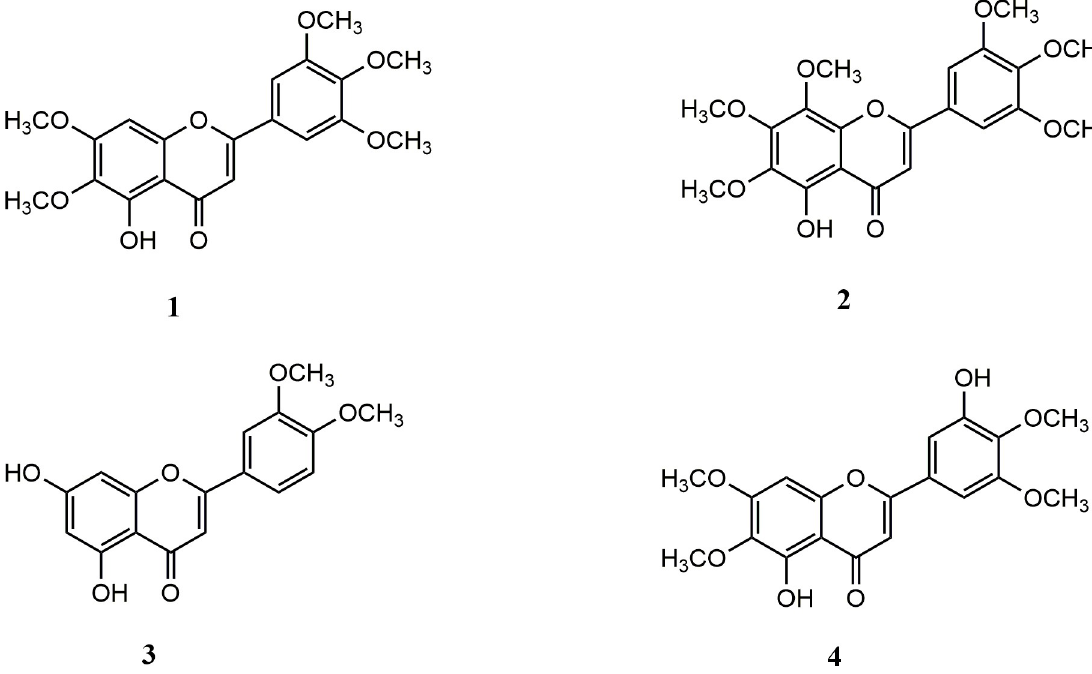
Fig 1. Chemical structures of isolated compounds from P . punctulata